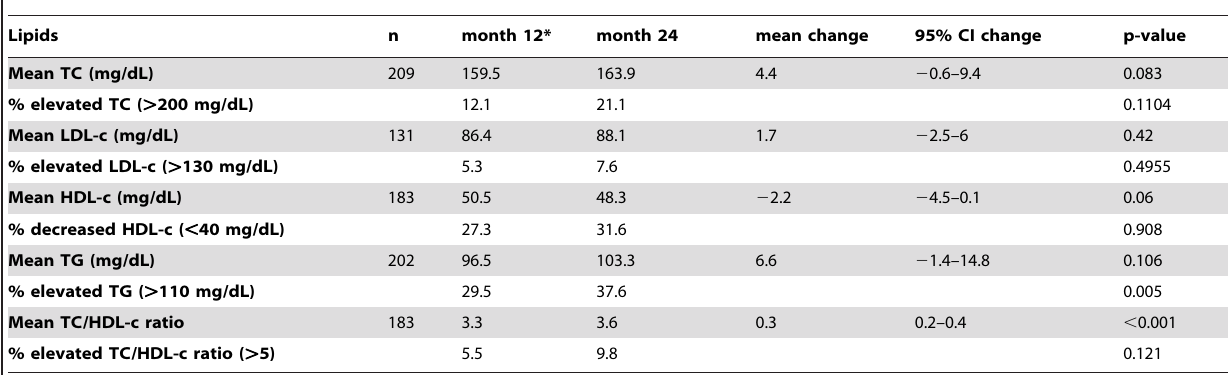
Table 3. Analysis of changes in serum lipid levels over time.